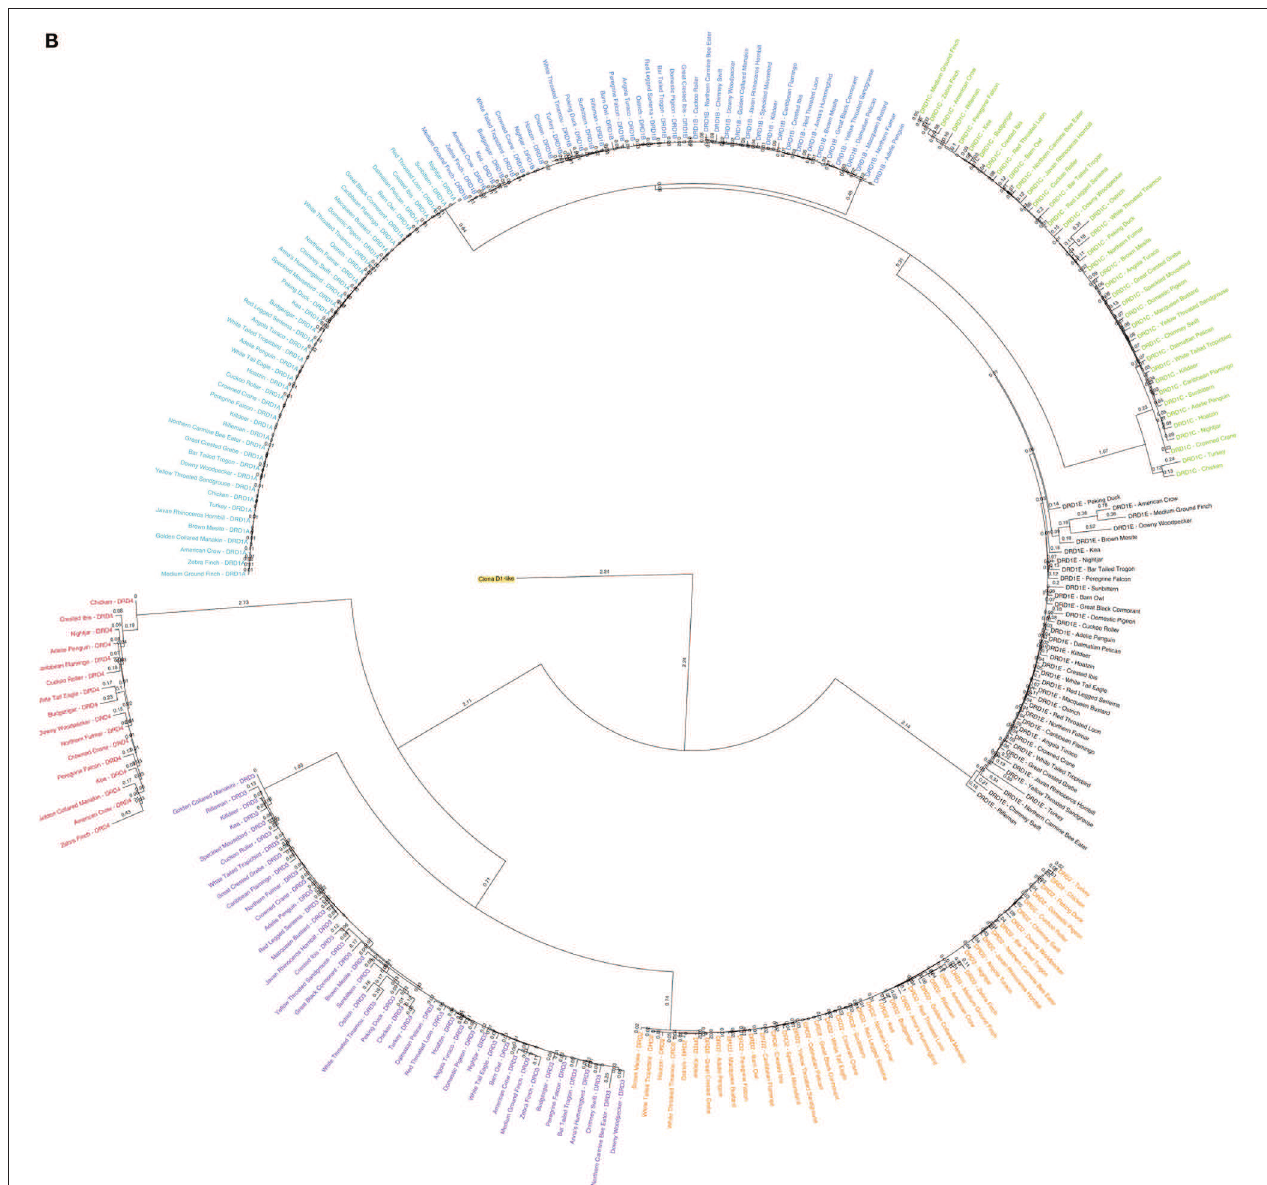
FIGURE 1 | Phylogenetic analysis of dopamine receptors in 43 bird species. Inferred maximum-likelihood evolutionary phylogeny of the 7 DA receptors found in birds based on protein sequences. The phylogeny is composed of two major clades: (1) The Class 1 (D1) receptors, with DRD1A in light blue, DRD1B in dark blue, DRD1C in green and DRD1E in black; and (2) The Class 2 (D2) receptors, with DRD2 in orange, DRD3 in purple, and DRD4 in red. Trees are rooted on the Ciona D1-like receptor (highlighted yellow). Calculations were performed using RAxML 8.1.2 (Stamatakis, 2014). (A) Cladogram of phylogenetic relationships with